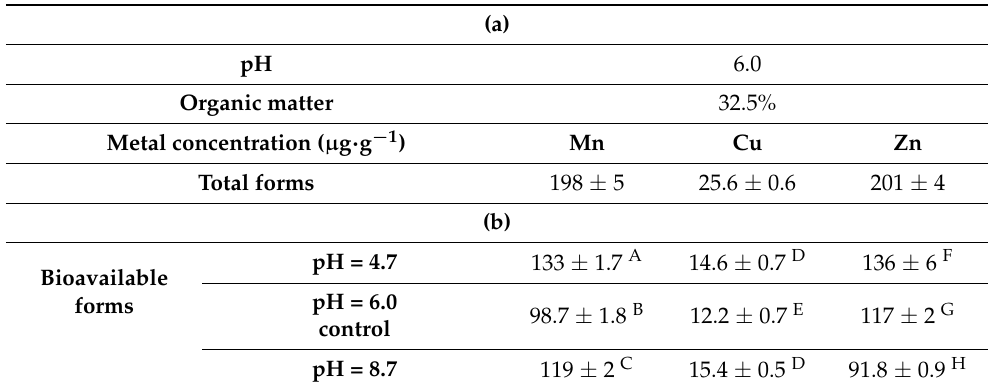
Table 1. Analysis of soil without additives ( a ). Bioavailable forms of Mn, Cu, Zn in either initial soil without additives (pH = 6.0) or modified soil samples with pH adjusted to 4.7 and 8.7, respectively ( b ). Specific letters illustrate the statistically significant differences as computed with the Tukey’s HSD test ( p = 0.95). (a) pH 6.0 Organic matter 32.5% Metal concentration ( µ g · g − 1 ) Mn Cu Zn Total forms 198 ±